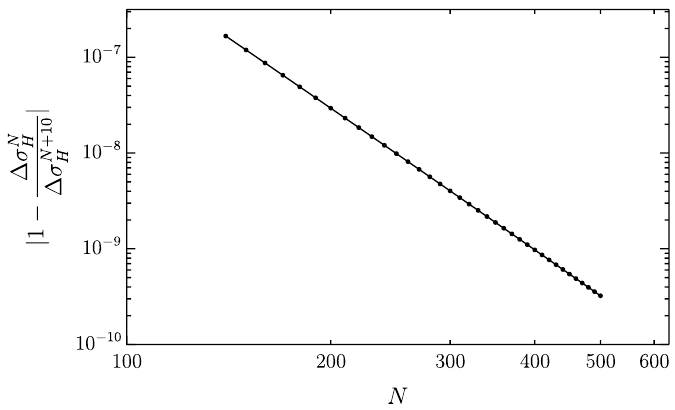
Figure 6 . Convergence of the O ( (cid:15) 3 ) coe(cid:14)cient of the entropy di(cid:11)erence for (cid:13) = 1 = 2. The conver- gence is power-law, which is consistent with the non-smooth decay at in(cid:12)nity. which are precisely those that follow from taking the fourth power of the sum of the two linear-order modes. Solving the associated system of ODEs we (cid:12)nd the corresponding Fourier coe(cid:14)cients f (4 ;(cid:11) ) ( z ) for (cid:11) = 0 ; (cid:1) (cid:1) (cid:1) ; 12, and k (3) = 0 (for reasons similar to those i that give k (1)